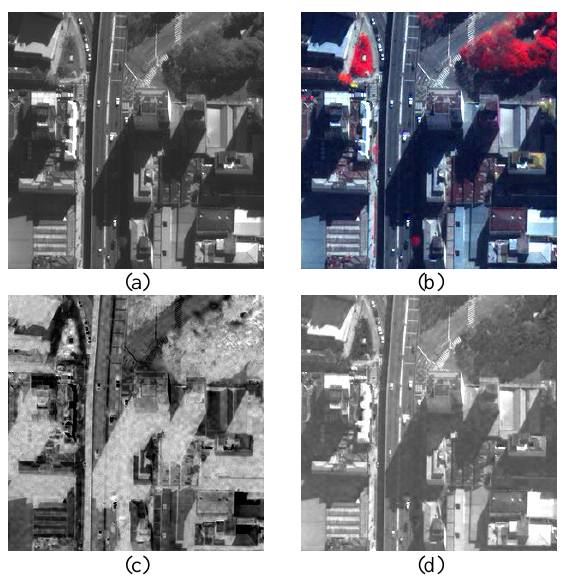
Figure 2. Examples of input image 1. (a)WV-2 Pan; (b) Pansharpened WV-2; (c) Component of S; (d)Component of V.